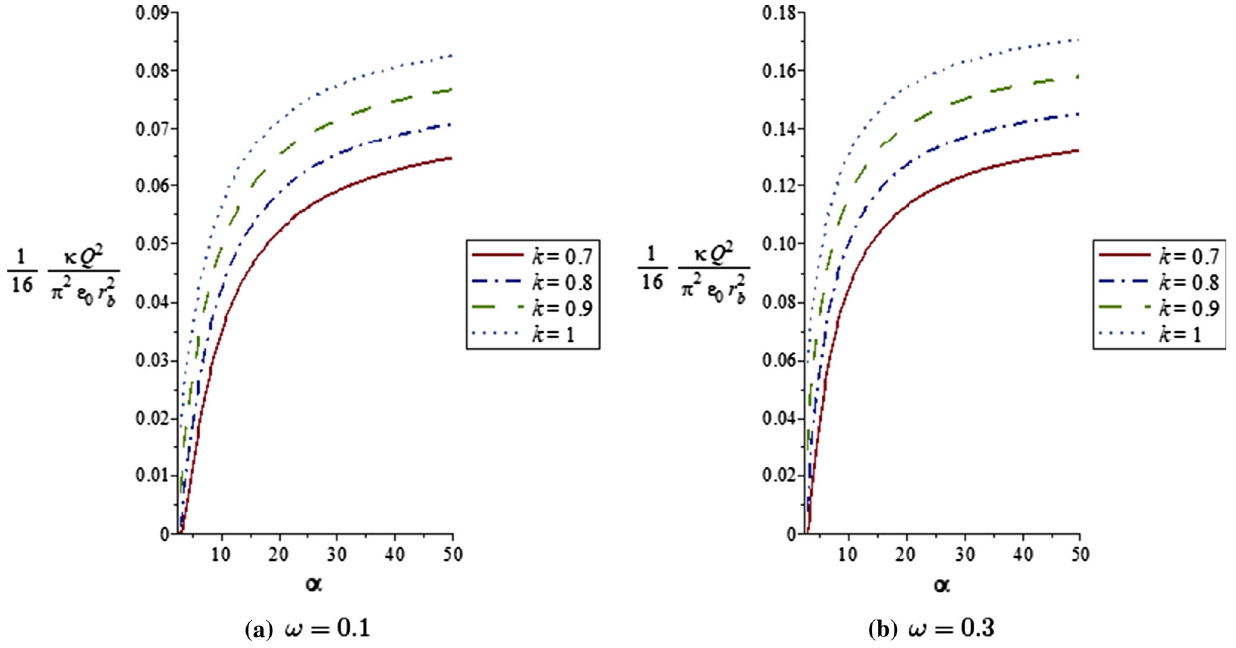
Fig. 2 The dimensionless quantity which is related with the total charge Q as a function of the parameter α for ω = 0 . 1( a ) and ω = 0 . 3 ( b